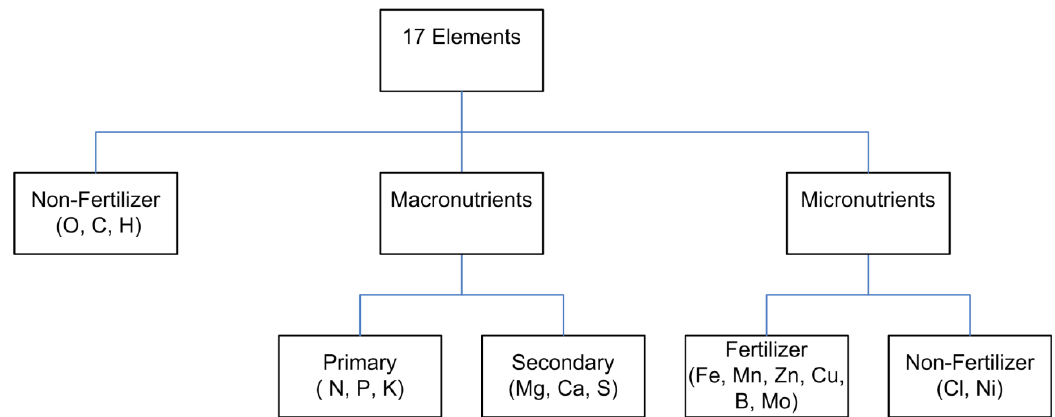
Figure 4. Categories of essential plant